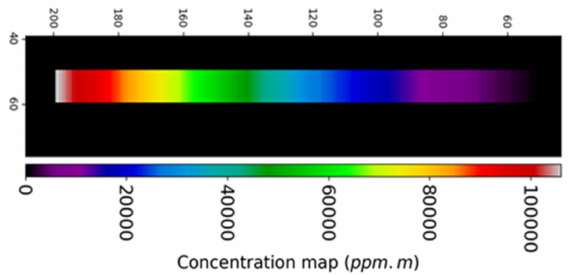
Figure A3. Concentration map of the synthetic plume (in ppm · m) used in the Section